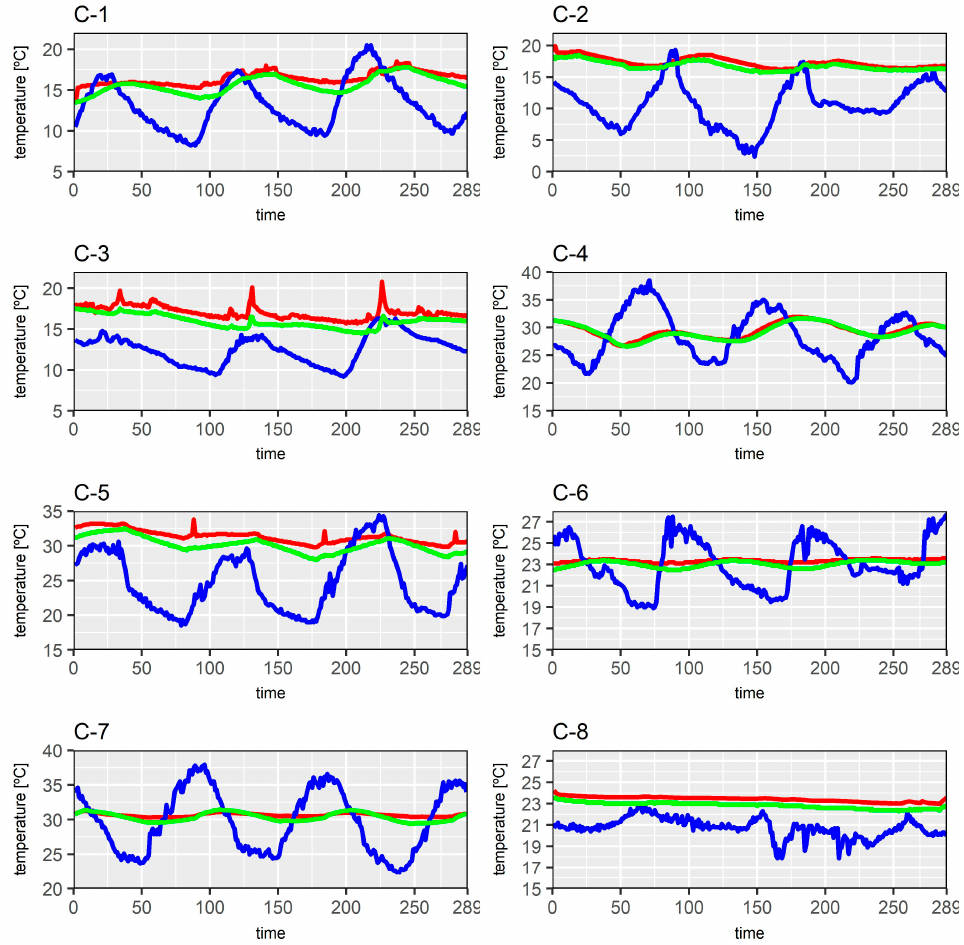
Figure 3. Values of the temperature measured by the probes of data logger A: the internal air temperature (red), the internal surface temperature of the wall (green), and the external air temperature (blue).